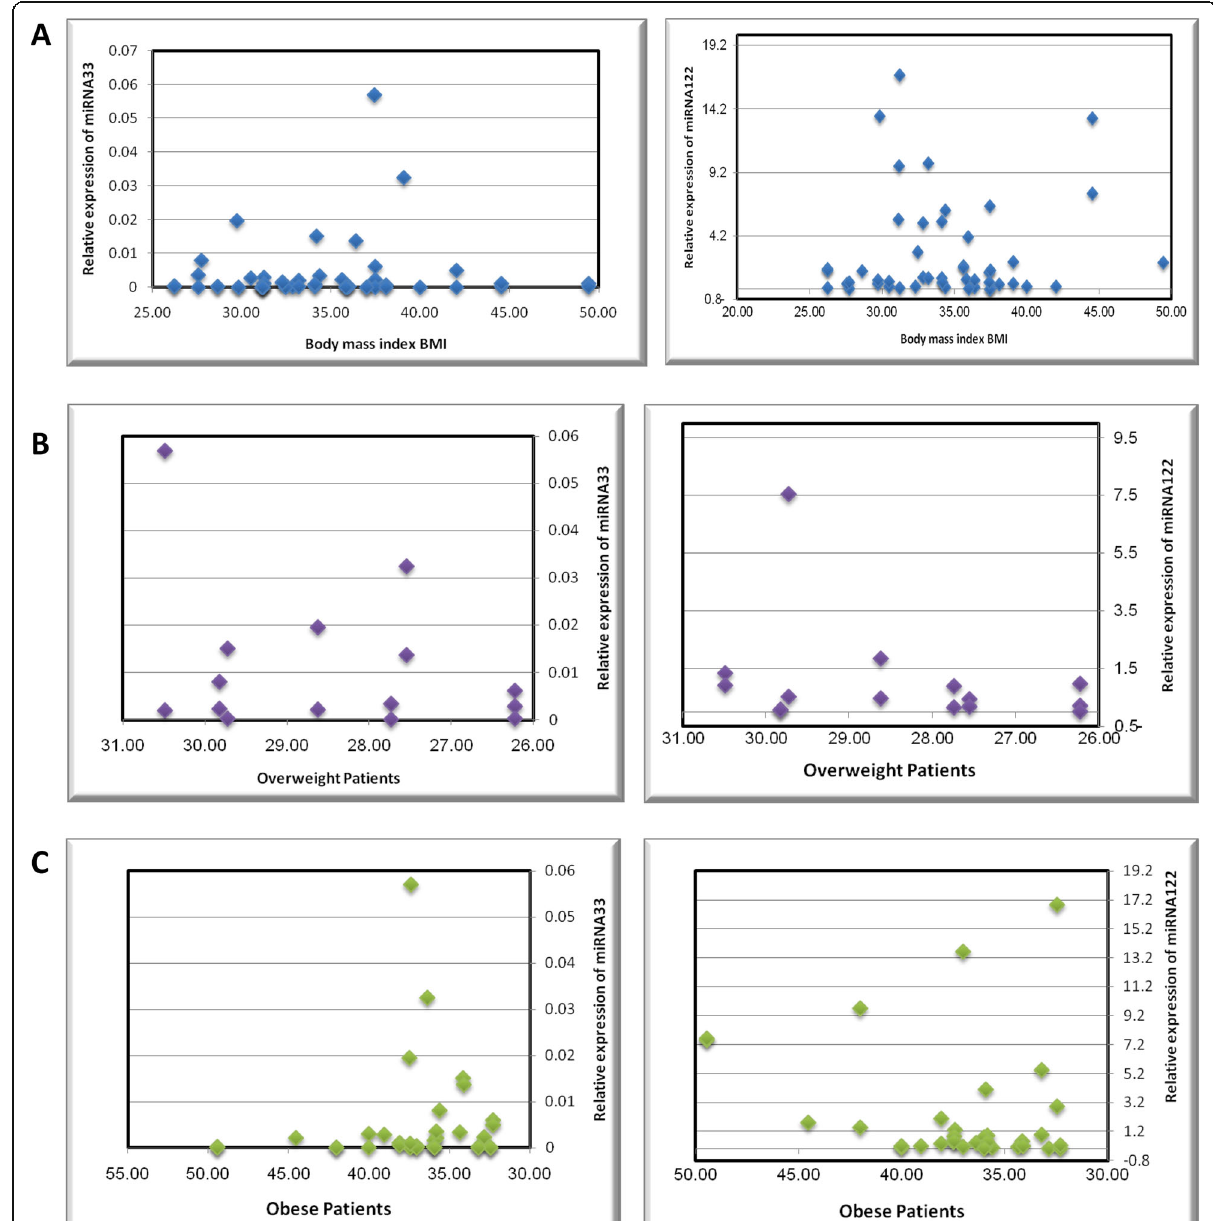
Fig. 2 Correlation of relative expression of miRNA-33 and miRNA-122 with body mass index ( A ), including overweight ( n = 30) ( B ) and obese patients ( n = 70) ( C